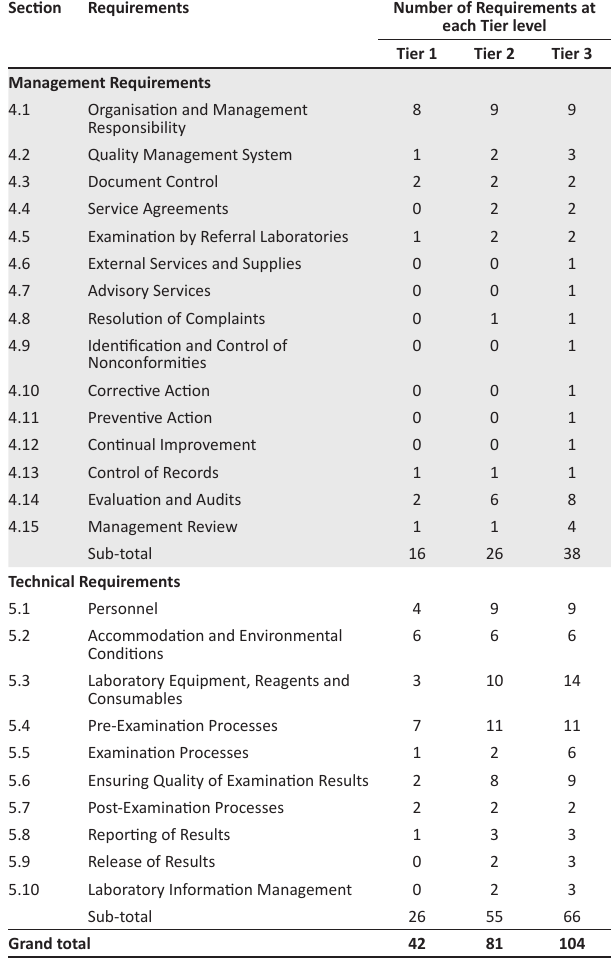
FIGURE 1: Flow chart of the Caribbean Laboratory Quality Management Systems Stepwise Improvement Process, showing the different steps for enrolment and participation of laboratories.